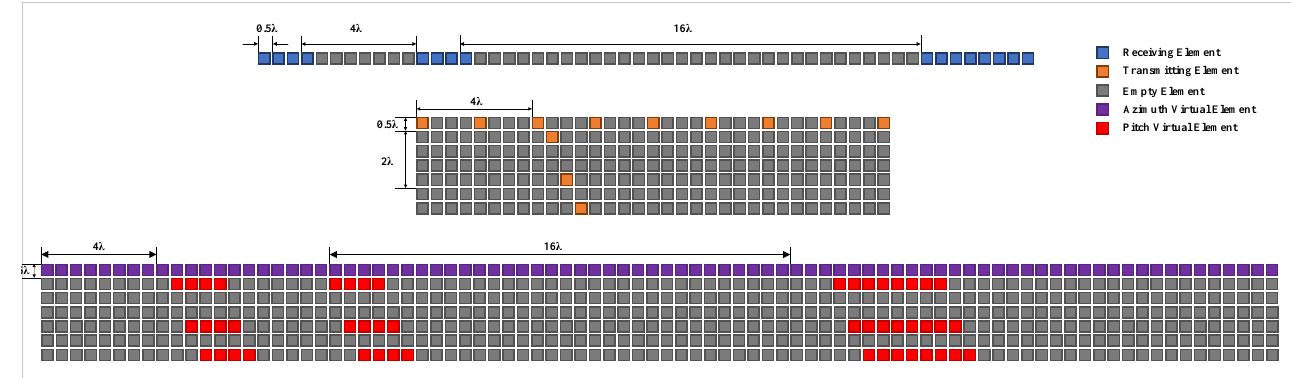
Figure 2. The selected elements and the remaining receiving